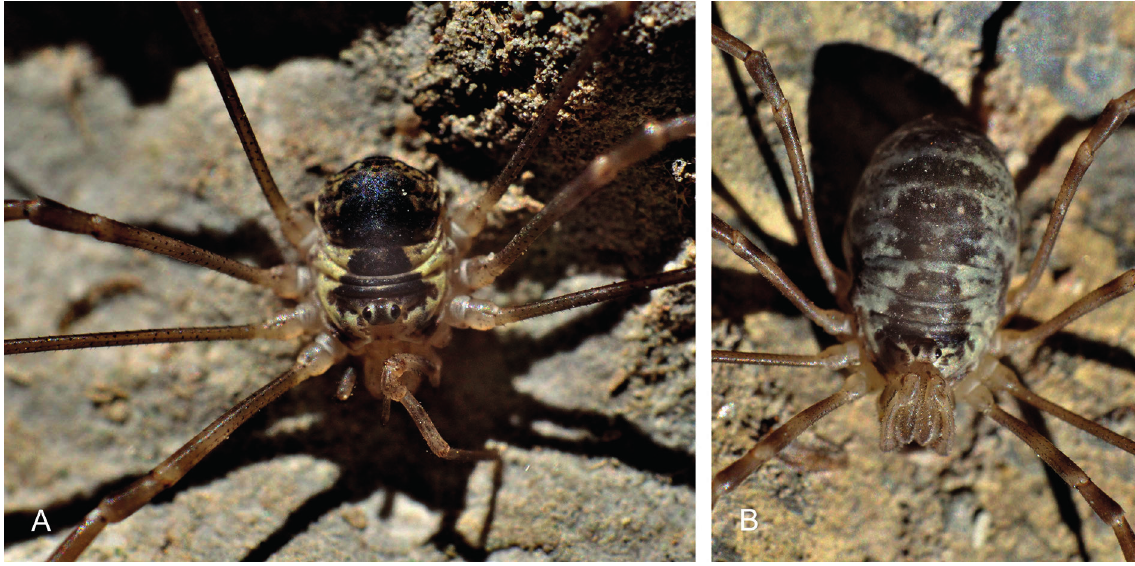
Fig. 18. Dicranopalpus pyrenaeus Dresco, 1948. Pic d’Orhy, Larrau, France, 15 Oct. 2019. A .